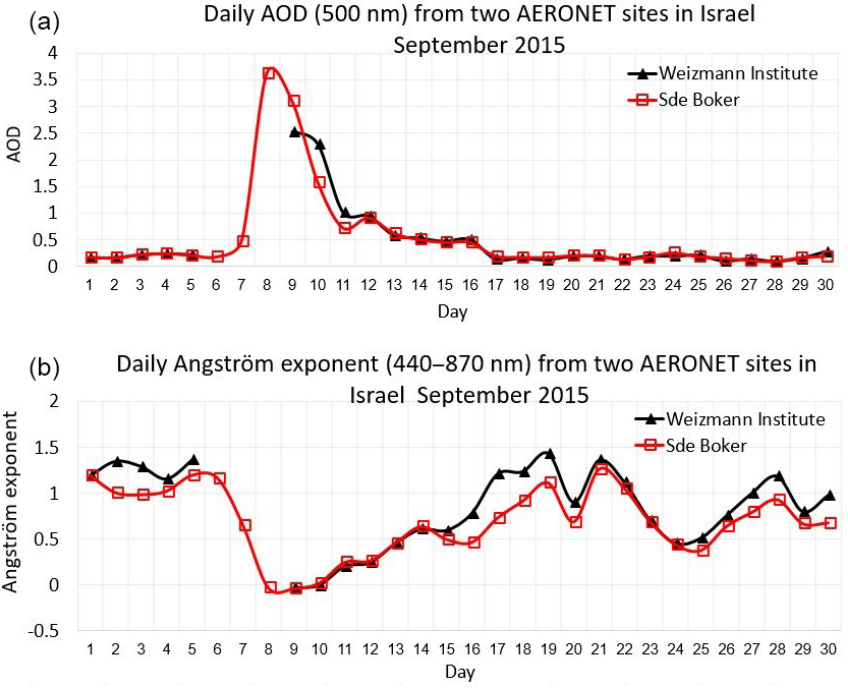
Figure 5. September 2015 daily average of AOD (a) and Ångström exponent (b) from two AERONET sites in Israel (Sde Boker and Weizmann; see Fig. 3). The Weizmann AERONET did not operate on 6–8 September due to power failure.